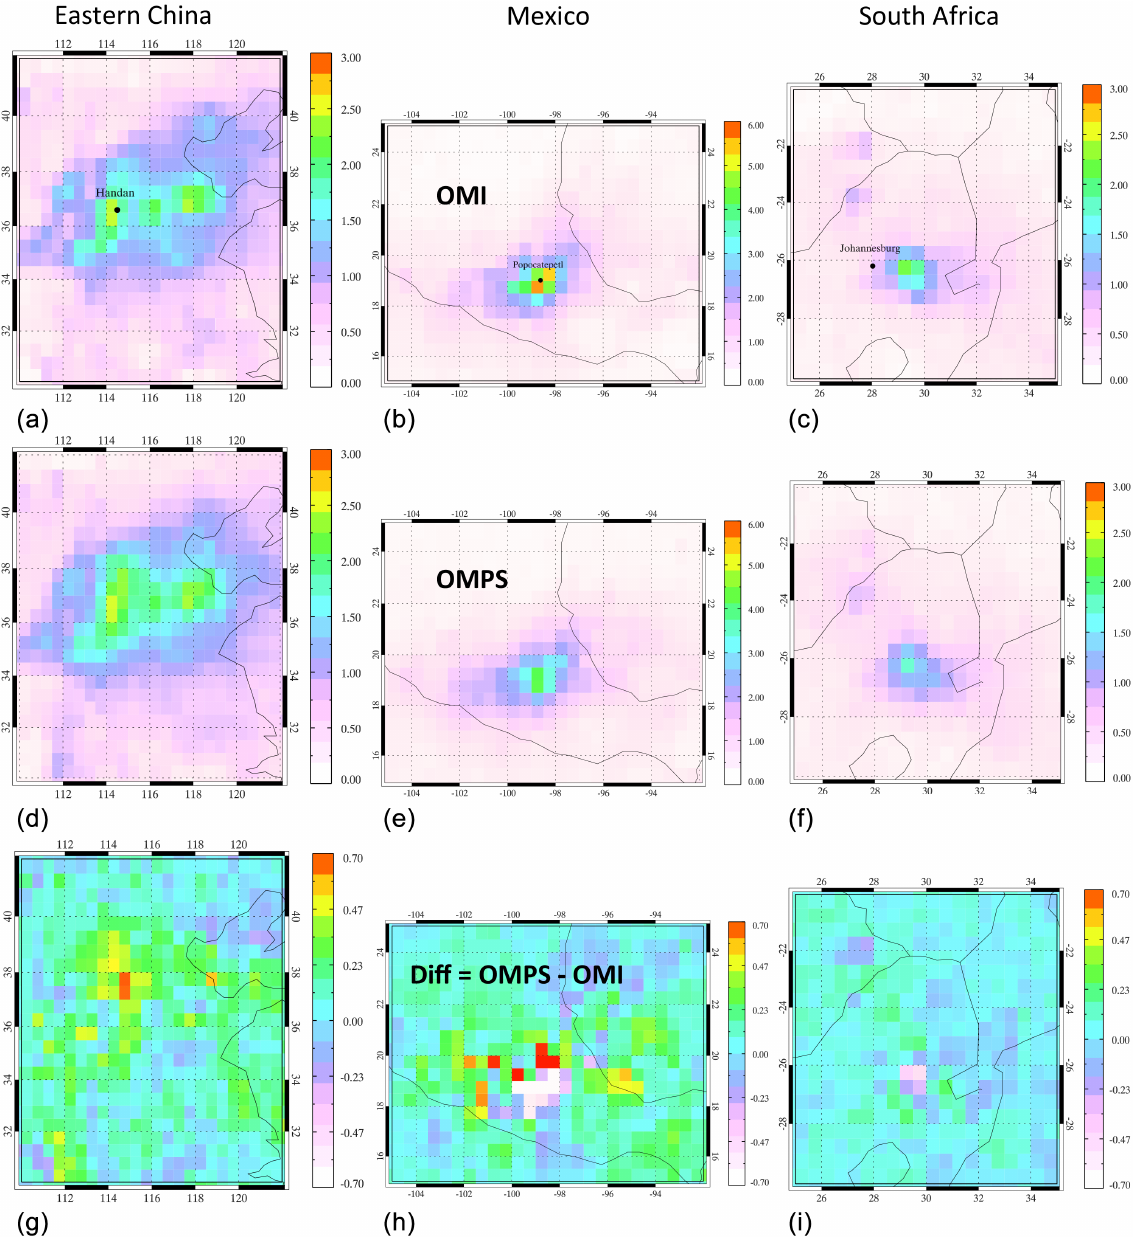
Figure 2. Annual SO 2 loading (unit: DU) over eastern China (left), Mexico (middle), and South Africa (right) for OMI (top), OMPS (center), and differences between OMPS and OMI (bottom, Diff = OMPS − OMI) in 2012. SO 2 columns amounts are gridded to 0.5 ◦ × 0.5 ◦ grid